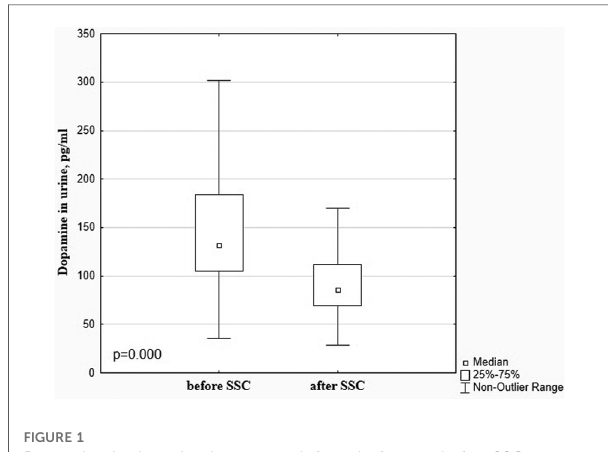
FIGURE 1 Dopamine in the urine in preterm infants before and after SSC.